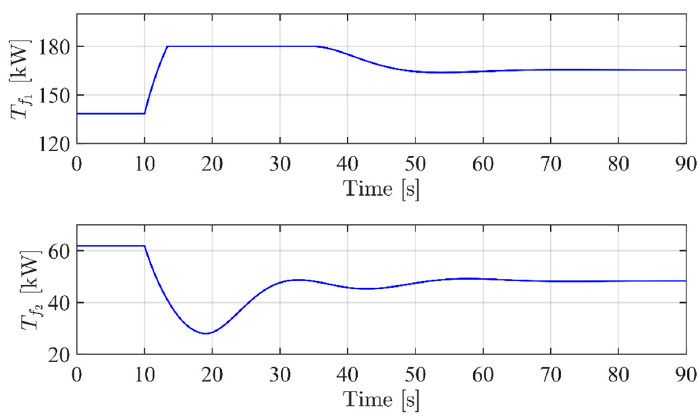
Figure 8. Profiles of the thermal flows injected in the two kilns. Machines 2018 , 6 , x FOR PEER REVIEW